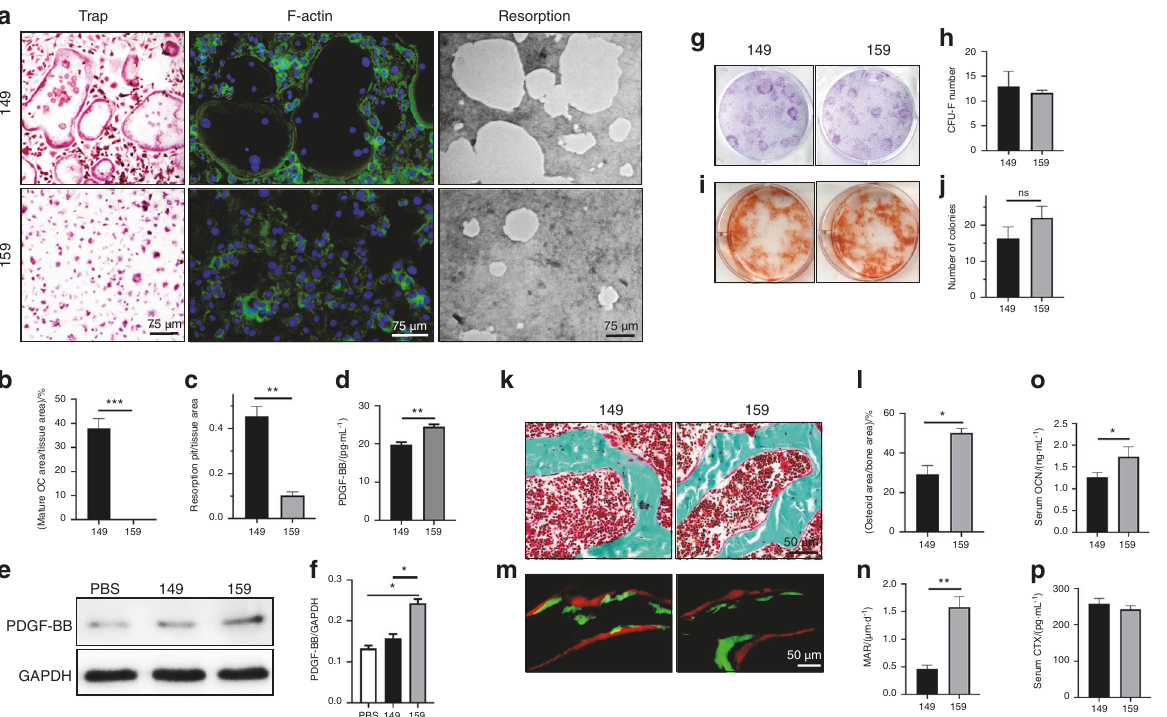
Fig. 4 Injection of a Siglec-15 neutralizing antibody halted the maturation of osteoclasts and increased bone formation. a Representative images of TRAP staining ( fi rst column), phalloidin staining (second column), and resorption pits (third column) of the osteoclast cultures that were induced from primary mouse bone marrow monocytes. All experiments were conducted on day 7 of osteoclastogenic induction. b , c Quantitative analysis of the TRAP staining and resorption area in a . ** P < 0.01, *** P < 0.001. d ELISAs of the concentration of PDGF-BB in the conditioned media that was collected on day 7 of osteoclastogenesis. ** P < 0.01. e Western blot of PDGF-BB in the cell lysate of osteoclasts on day 7 of osteoclastogenic induction. f Quantitative analysis of blot size in e . * P < 0.05. g , h Crystal violet staining and quantitative analysis of bone marrow stromal cells cultured for 10 days. i , j Alizarin red staining of bone marrow stromal cells cultured in osteogenic medium for 21 days. Bone marrow stromal cells were collected from 4-month-old mice that received NP-149 or NP-159 injection for 1 month. ns: not signi fi cant. k Trichrome staining of femurs collected from the mice treated with NP-149 or NP-159 for 2 months. The osteoid layer is labeled red. l Quantitative analysis of the osteoid-covered surface. n = 5, * P < 0.05. m Double labeling of the mineral layers in mouse femur trabecular bone. The mice were treated with NP-149 or NP-159 for 1 months. n Quantitative analysis of the mineral apposition rate in m . n = 5, ** P < 0.01. ELISAs of OCN ( o ) and CTX ( p ) in the serum from the mice treated with NP-149 or NP-159 for 1 month. n = 5, * P < staining showed that NP-159 treatment increased the bone the NP-159-treated mice compared to the NP-149-treated mice formation rate in the PDGFB f/f mice, as evidenced by increases in (Fig. 4o). In contrast, there was no difference in the serum CTX levels between these two groups of mice (Fig. 4p). These data the mineral apposition rate (Fig. 5h, i), osteoid surface area (Fig. 5j, suggest that the Siglec-15 neutralizing antibody can inhibit k), and number of osteoblasts (Fig. 5l, m). Again, no differences osteoclast bone resorption while promoting bone formation. were observed in the PDGFB − / − mice relative to the NP-149-treated PDGFB f/f mice for these parameters (Fig. 5h – m). Coimmuno fl uores- Knockout of PDGF-BB in TRAP + lineage cells blunted the effect of cence staining of CD31 and EMCN showed that the increase in type H vessels induced by NP-159 treatment was blunted in the PDGFB − / the Siglec-15 neutralizing antibody on bone formation − mice (Fig. 5n, o). To determine whether the effect of NP-159 To further investigate whether PDGF-BB secreted by TRAP + mononuclear cells mediates Siglec-15 neutralizing antibody- treatment on osteoclastogenesis was altered by PDGFB knockout, induced bone formation, we generated PDGF-BB conditional we performed TRAP staining. The differences between the mice knockout mice ( PDGFB − / − ) by crossing TRAP-Cre mice with PDGF- treated with NP-159 and NP-149 in the number and size of osteoclasts were similar in both the PDGFB f/f and PDGFB − / − mice BB fl ox/ fl ox mice, in which PDGFB was speci fi cally deleted in TRAP + lineage cells. Adult PDGFB − / − mice and their age-matched WT (Fig. 5p, q). These data indicate that although the Siglec-15 littermates ( PDGFB f/f ) were injected with different antibodies twice neutralizing antibody blocked the maturation process of osteoclasts in both PDGFB − / − mice and PDGFB f/f mice, the lack of PDGF-BB weekly for 2 months. The effect of the Siglec-15 neutralizing antibody NP-159 on bone formation was abolished in the PDGFB − / − secretion by TRAP + mononuclear cells mediated the anabolic effect of the Siglec-15 neutralizing antibody on bone formation. mice relative to the PDGFB f/f mice. In µCT analysis, the PDGFB f/f mice injected with NP-159 showed signi fi cantly higher BV/TV (Fig. 5a, b) and Tb. N values (Fig. 5a, c), as well as lower Tb. Sp Injection of a Siglec-15 neutralizing antibody prevented bone loss values (Fig. 5a, d), relative to the PDGFB f/f mice injected with NP- in estrogen-depleted osteoporotic mice 149. This anabolic effect was absent in the PDGFB − / − mice To investigate the therapeutic potential of the Siglec-15 neutralizing antibody for treating bone loss, we examined the effect of Siglec-15 (Fig. 5a – d). We did not observe a signi fi cant difference in cortical antibodies in an ovariectomized (OVX) mouse model in which bone parameters among the different groups of mice except the estrogen depletion induces osteoporosis. In this experiment, we trend of bone volume increase between the NP-159- and NP-149- compared the effect of one Siglec-15 antibody engineered with two treated PDGFB f/f mice (Fig. 5a, e – g). Double labeling and trichrome